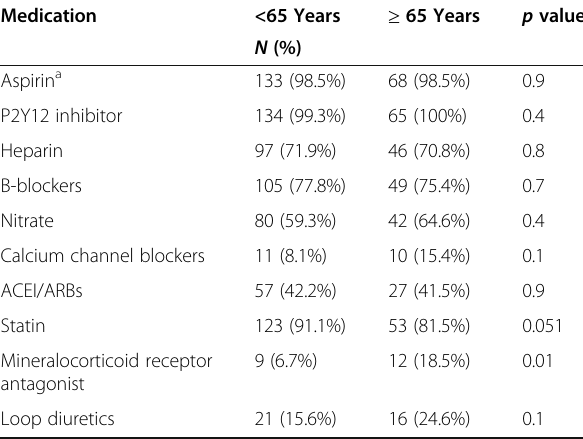
Table 2 Pharmacotherapy profile in patients with NSTE-ACS according to age category